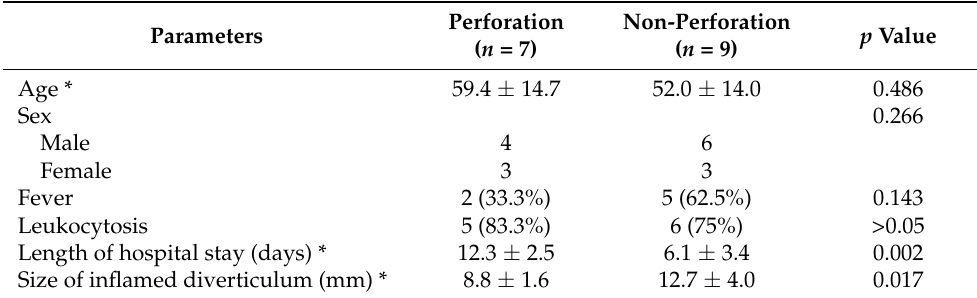
Table 4. Comparison of clinical features and diverticular size between perforation and non- perforation